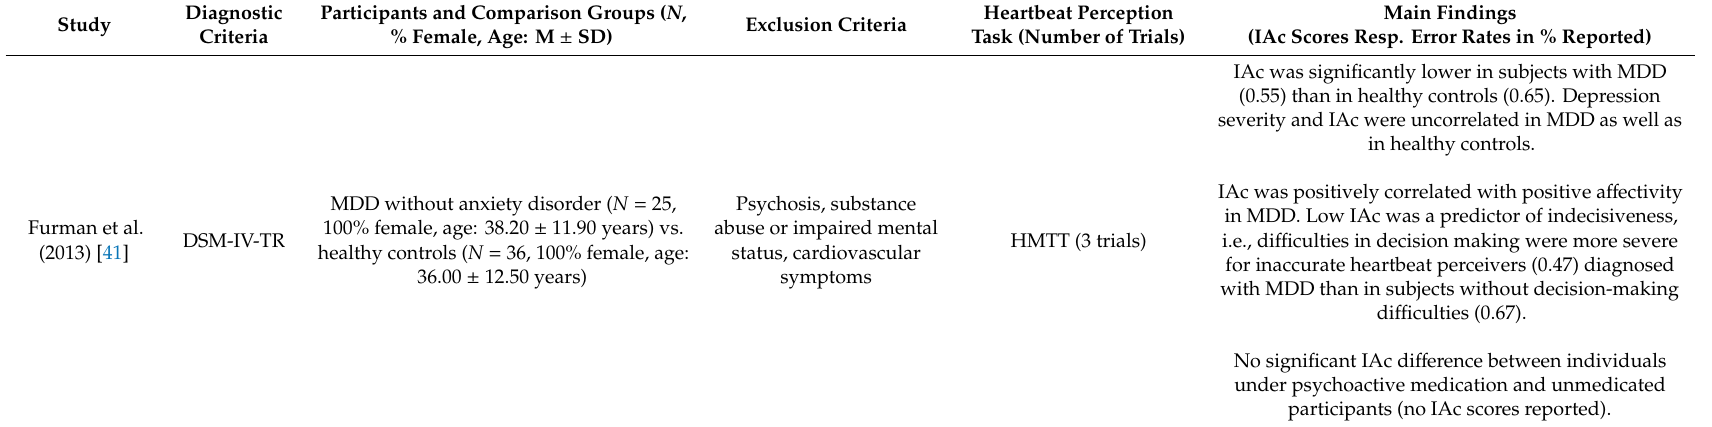
Table 1. Characteristics of included